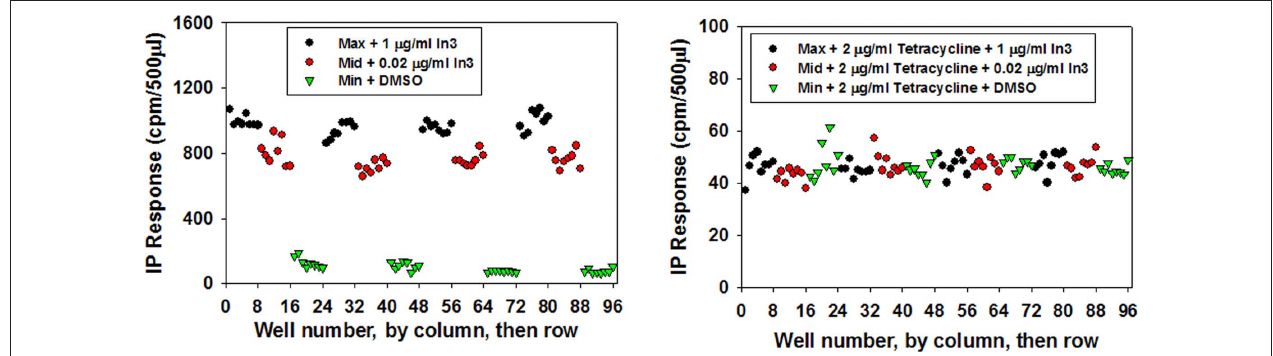
FiGurE 4 | The same data as in Figure 3, but re-graphed by column, then row in order to reveal any “edge” effects or other artifacts due to the